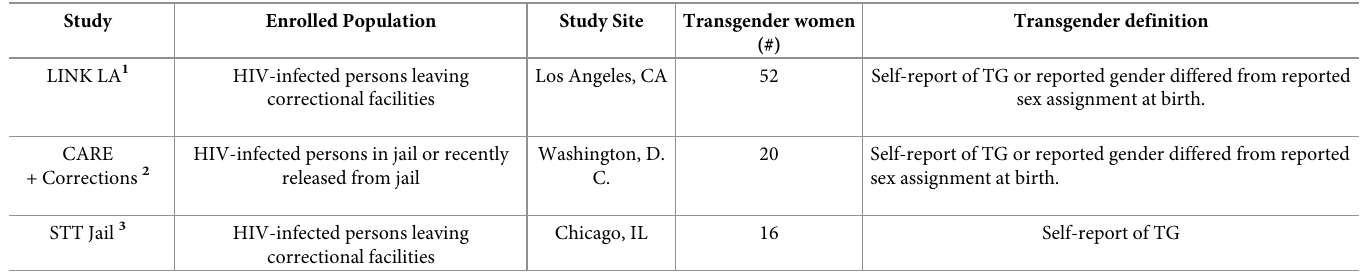
Table 1. Participating studies, enrolled populations, study site, number of transgender women study